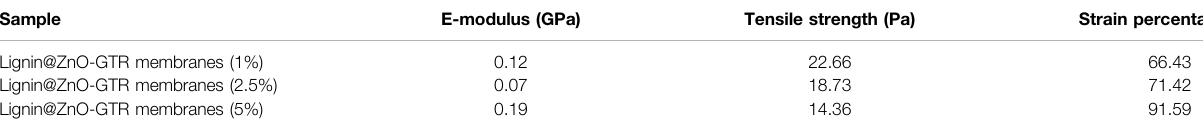
TABLE 2 | E modulus, strain (percentage), and tensile strength of the synthesized 1, 2.5, and 5% Lignin@ZnO-GTR membranes.